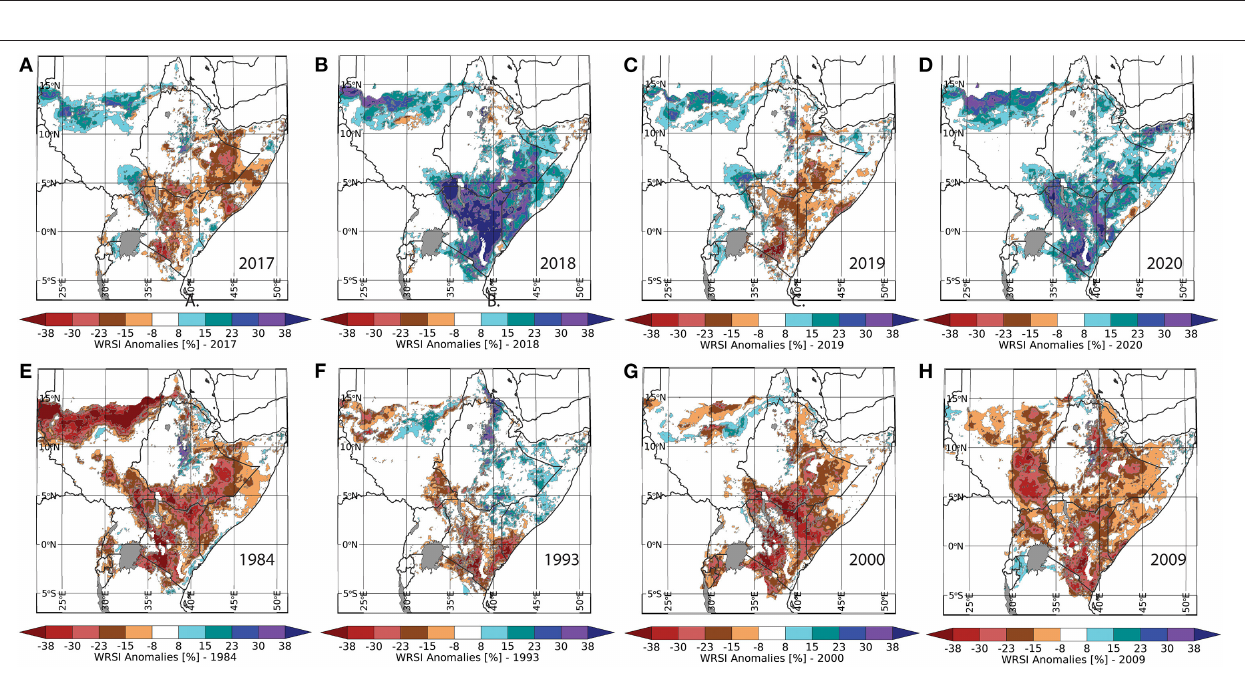
FIGURE 4 | End-of-season WRSI anomalies for the four most recent years ( A 2017, B 2018, C 2019, D 2020) and four extremely dry prior years ( E 1984, F 1993, G 2000, H 2009).